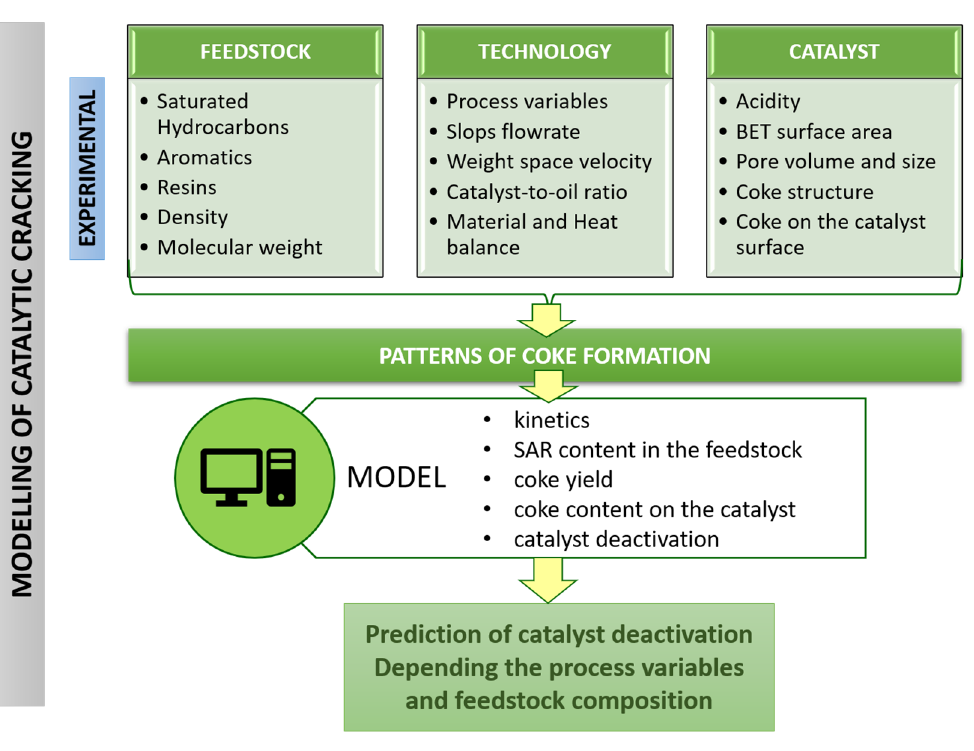
Figure 2. An approach for accounting for catalyst deactivation during modeling.